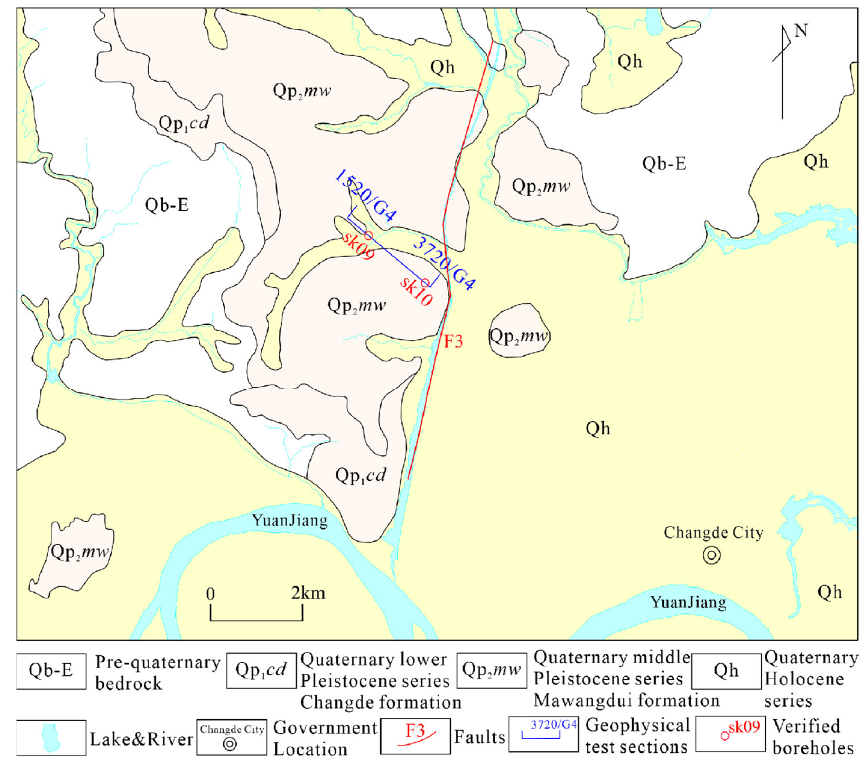
Figure 1. Location map of geological and geophysical test sections in the study area (revised from 1:50,000 Chang-de regional geological map).